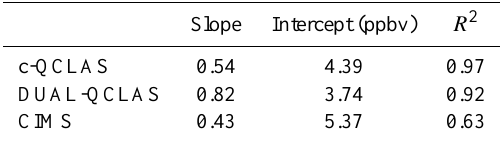
Table 3. Summary of linear regression results of the OP-FTIR against c-QCLAS, DUAL-QCLAS and CIMS at 2min time reso- lution from the data shown in Fig.